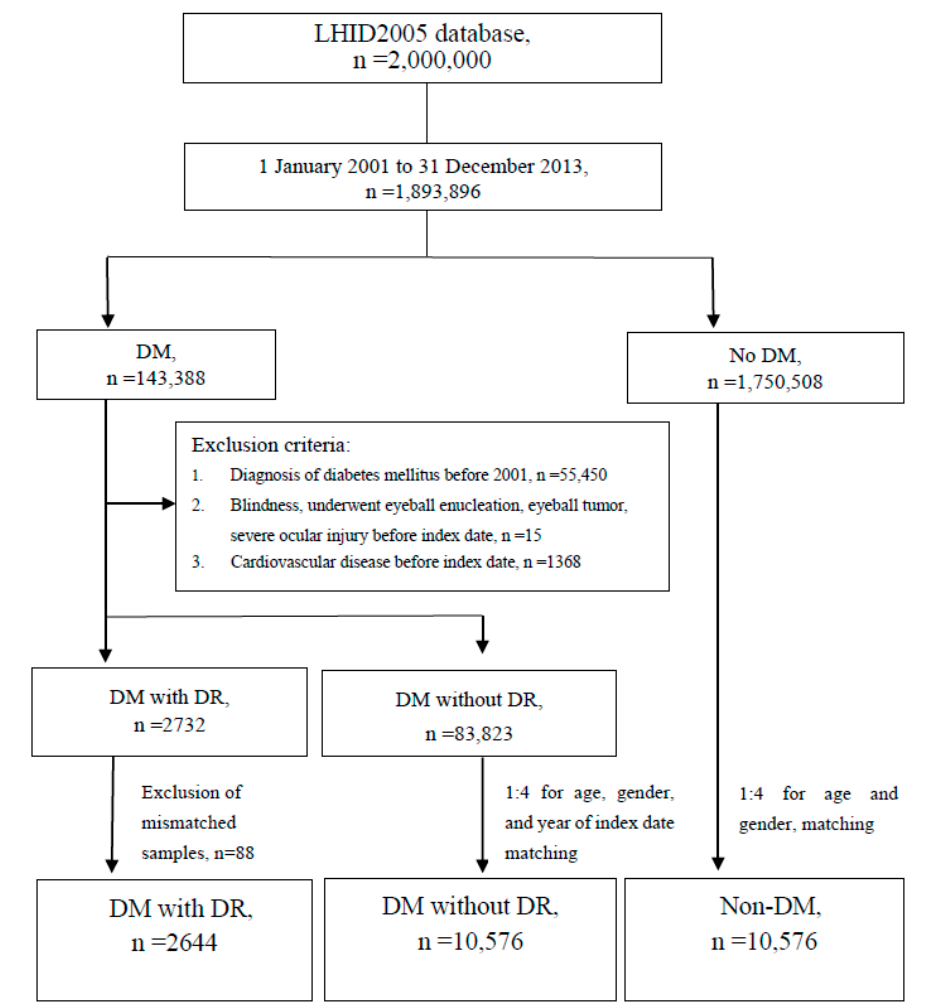
Figure 1. Study Figure 1. Study flowchart.